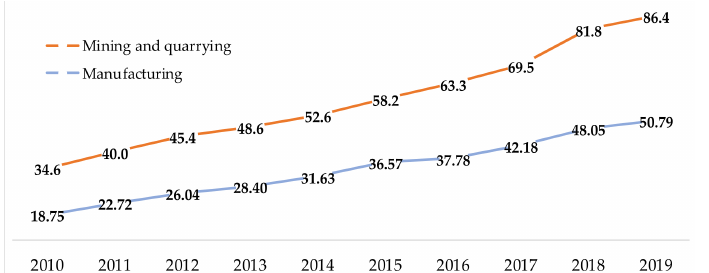
Figure 2. Change of aggregate indicator of sustainable development of industry in Russia.